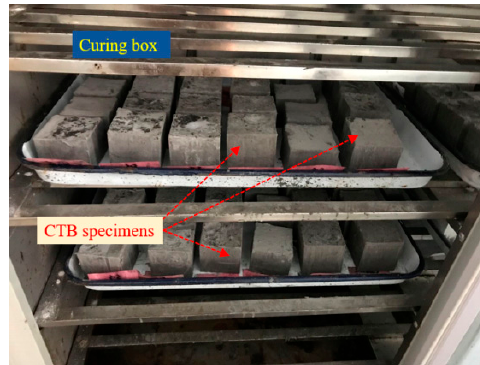
Figure 4. The preparation process of cement tailings backfill (CTB) mixes.